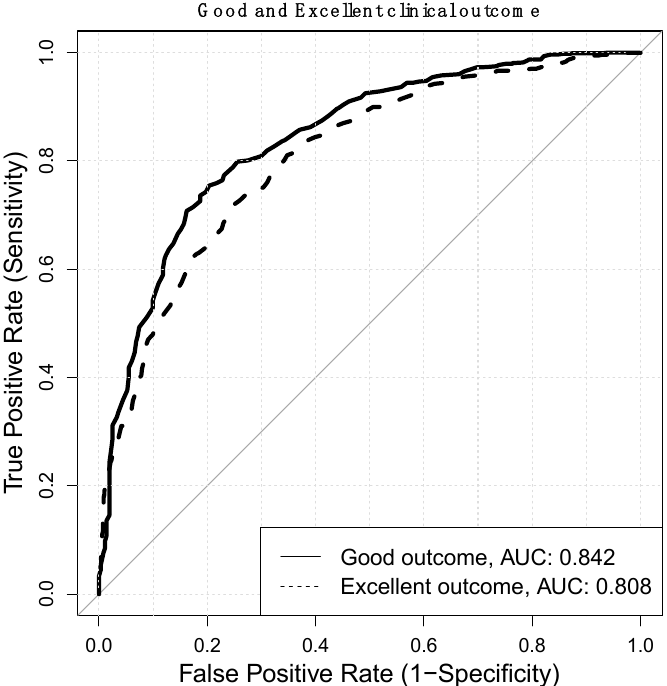
Figure 1. ROC CURVE for the ODI model and the combined model.